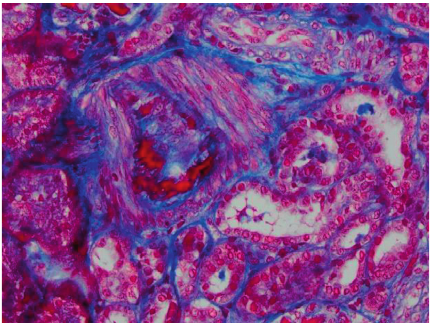
Figure 4: Intimal fibrinoid changes in interlobular artery (tri- chrome stain). Same interlobular artery is shown in figure 3.